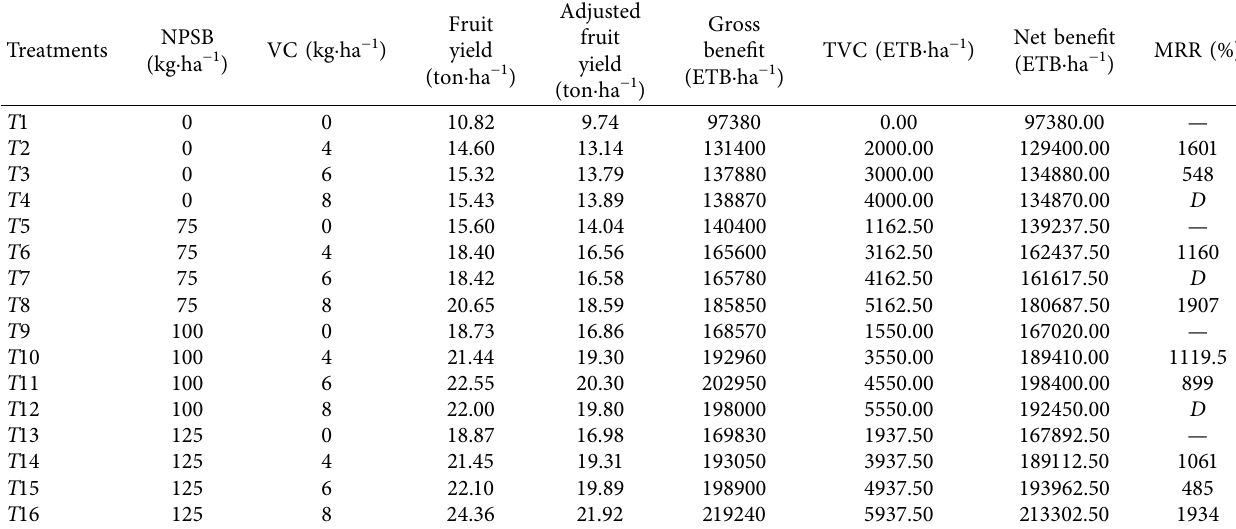
Table 6: Te over years (2021 and 2022) economic evaluation of fruit yield under the efect of NPSB and vermicompost fertilizers rates. Treatments